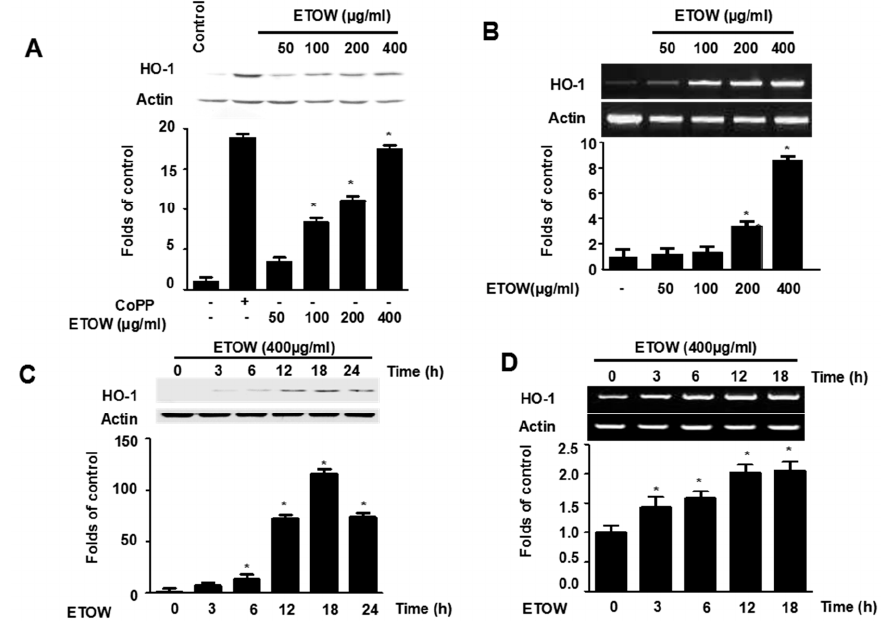
Figure 3. Effects of ETOW on HO-1 protein and mRNA expression in HT22 cells. HT22 cells were incubated for 12 h with various concentrations (50, 100, 200, 400 μ g/mL) of ETOW ( A , B ). HT22 cells were incubated with 400 μ g/mL of ETOW for various periods ( C , D ). CoPP (20 μ M) was used as a positive control. The expression of HO-1 protein (A,C) and mRNA (B,D) were assessed by Western blot and RT-PCR, respectively. Protein and gene expression results for HO-1 were normalized to actin. Each bar represents the mean ± SD ( n = 3). * p < 0.05 compared to the control group. The “+”and “ − ” signs indicates the presence or absence. Nutrients 2018 , 10 , x FOR PEER REVIEW